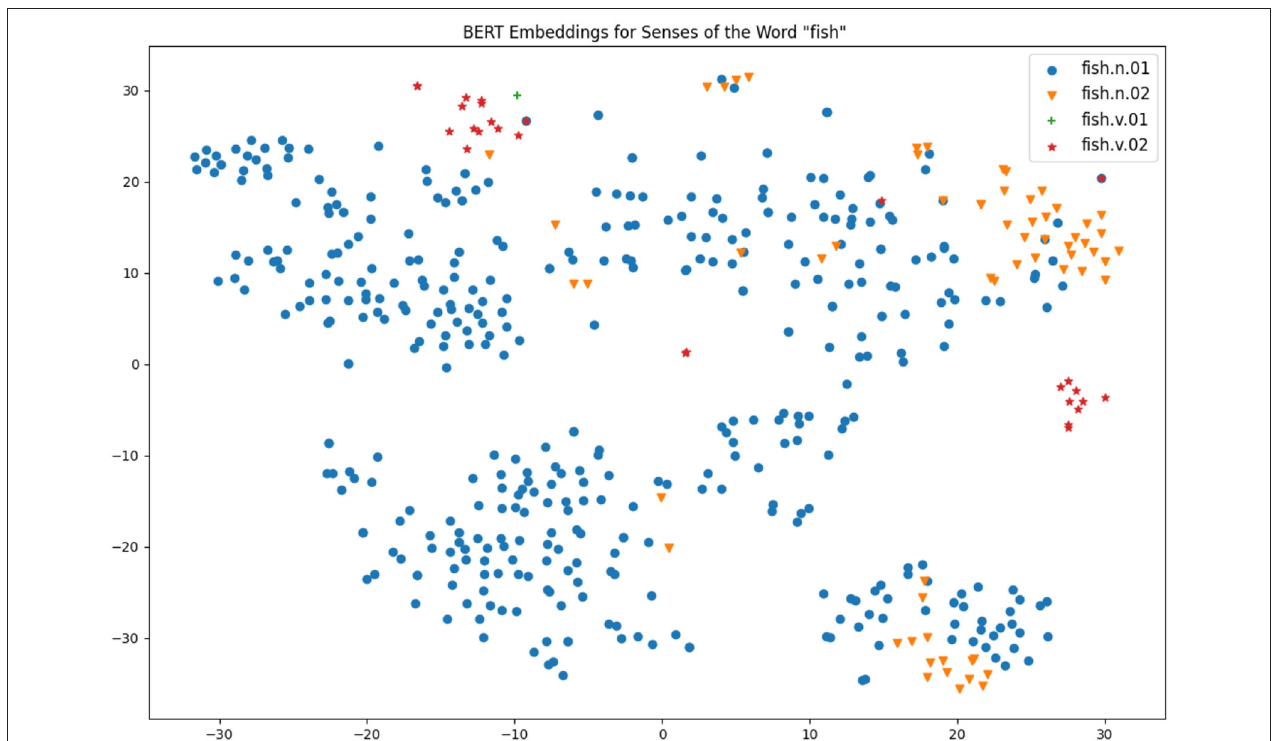
FIGURE 5 | Visualizations of BERT embeddings for different uses of fish.